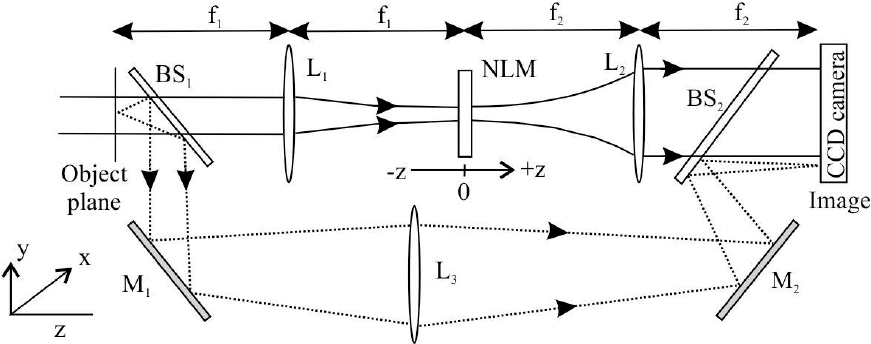
Figure 1. 4f imaging system: L—lenses (f1 = f2); BS—beam splitters; M—mirrors.